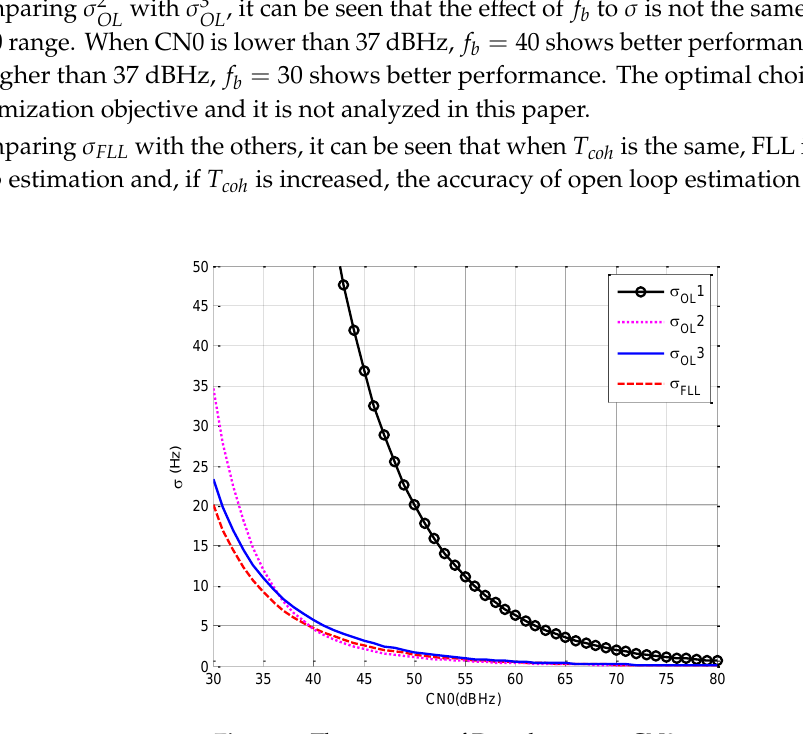
Figure 5. The accuracy of Doppler versus CN0.